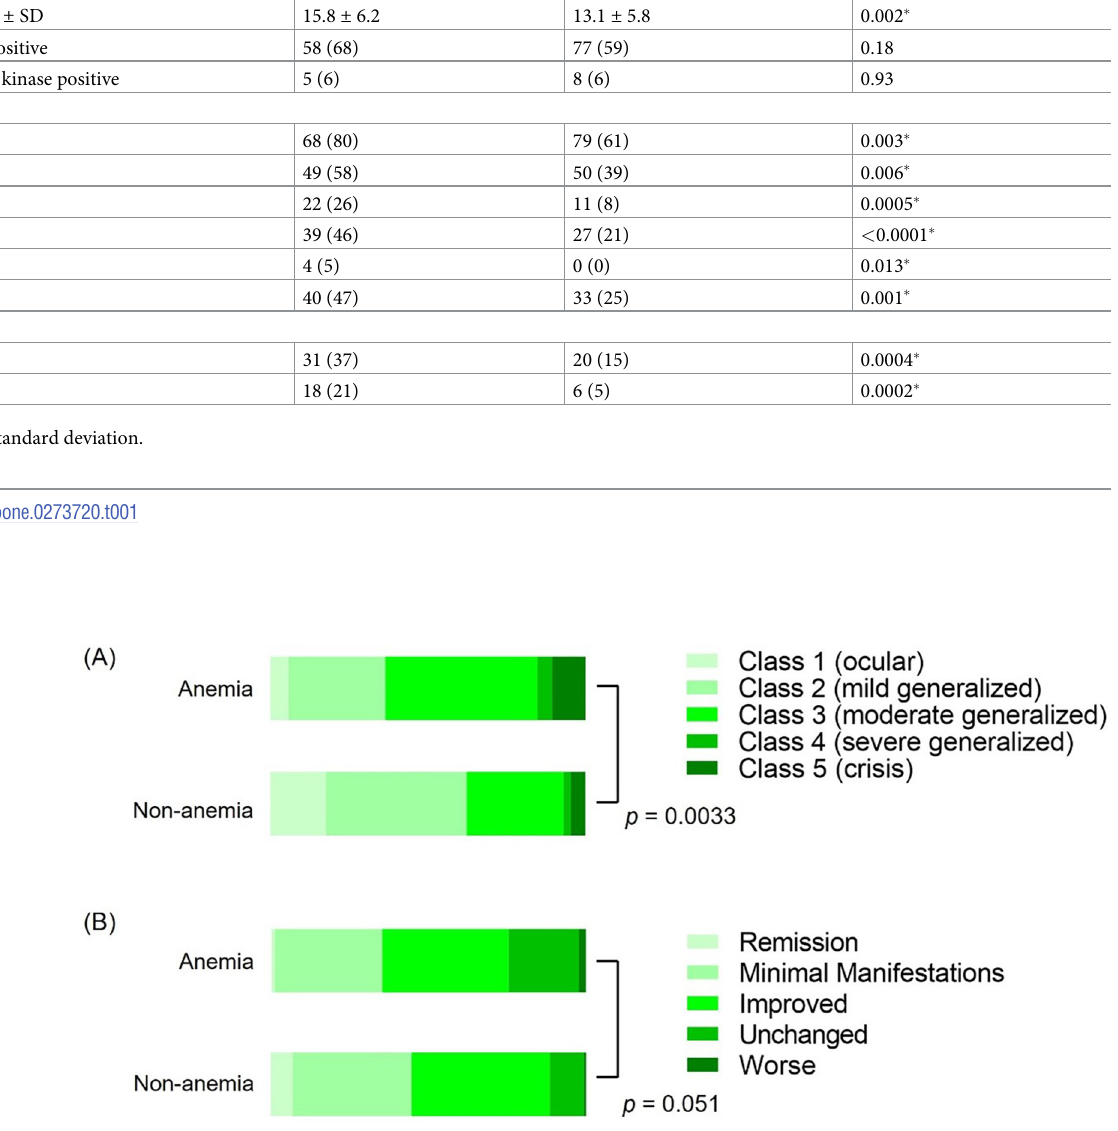
Fig 2. Disease classification (A) and post-interventional status (B) of 215 female myasthenia gravis (MG) patients. These assessments followed the recommendations of the MG Foundation of